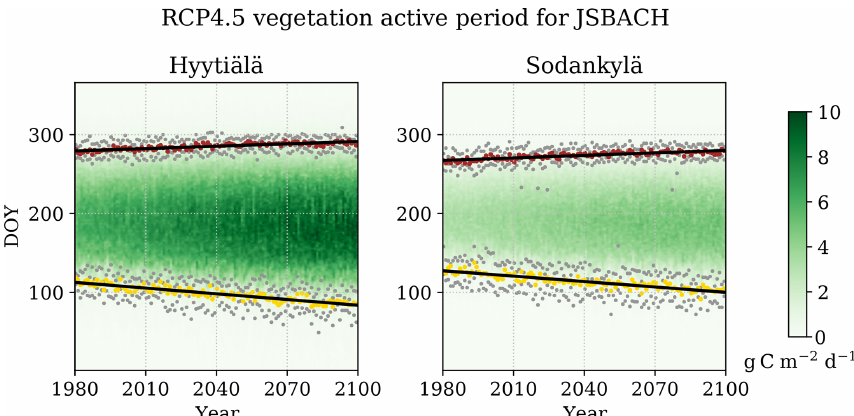
Figure 5. Average vegetation active period for JSBACH RCP4.5; yellow dots are the SOS values, red dots are the EOS values, and the grey dots are the minimum and maximum SOS and EOS from all simulations. Also presented are the trend lines and the daily GPP as the green